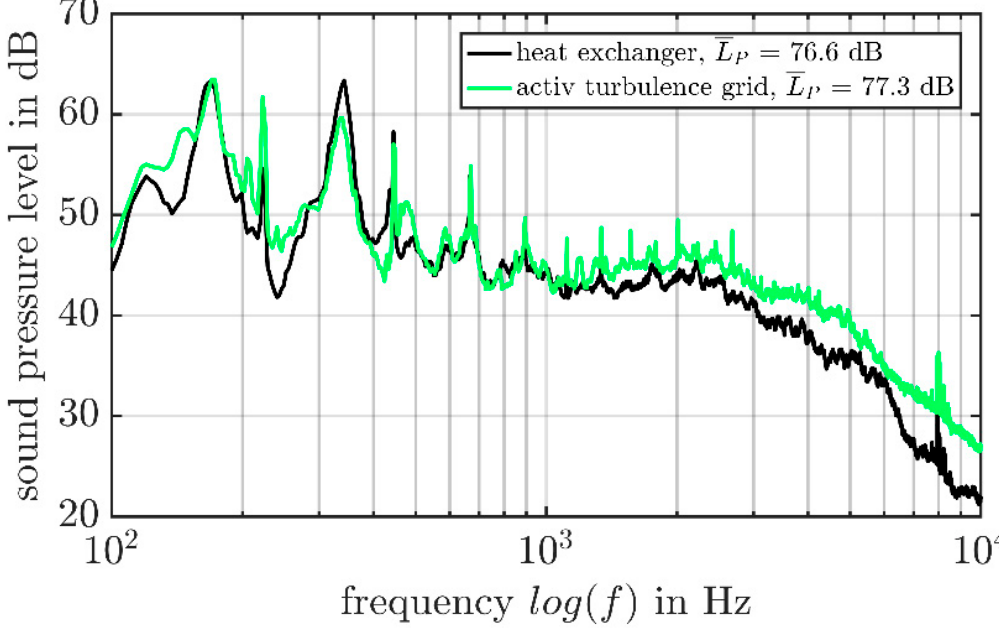
Figure 12. Sound pressure spectra of the heat exchanger ( Tu glo = 8.12%, Λ = 8.34 mm) and the active turbulence grid ( Tu glo = 8.15%, Λ = 10.48 mm) at the design point ( 𝑉(cid:4662) = 1.4 m 3 /s).